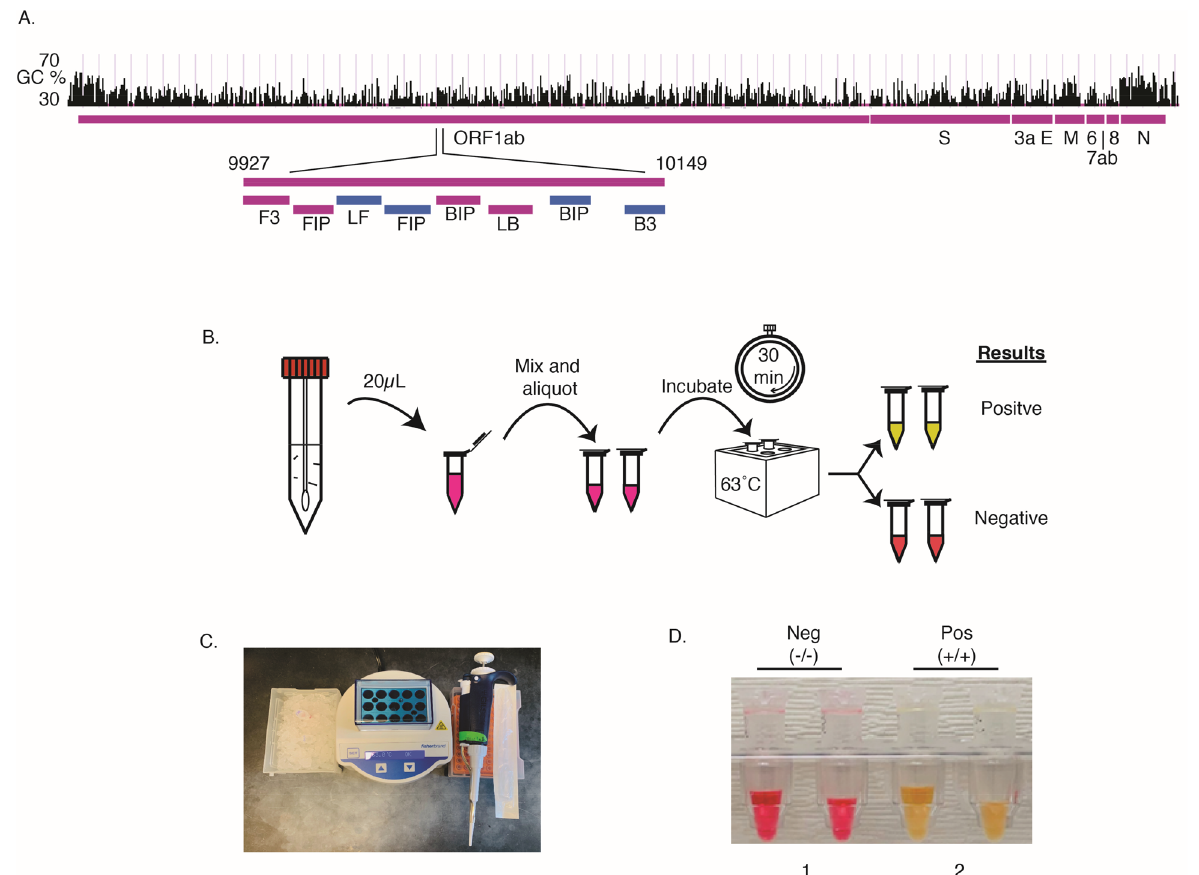
Figure 1. An RT-LAMP assay for rapid and direct SARS-Cov-2 testing of clinical sample and the point-of-care. ( A ) Primer design. A set of 6 LAMP primers targeting the middle of the Orf1ab gene. Sequences and primers matching to the + strand of virus genome are in pink, while those matching to the—strand are shown in blue. Illustration of GC% of SARS-CoV-2 genome was from UCSC genome browser (http://genom e.ucsc.edu) 17,18 . ( B ) Workflow of direct RT-LAMP assay. 20 µL of raw clinical samples from nasal swab in viral transport media (VTM) was added to 480 µL reaction solution consisting of reaction master mix and lysis buffer, mixed and 250 µL were aliquoted with a transfer pipette and then incubated on heatblock for 30 min. The reaction was stopped by placing the samples on ice and results were interpreted by color due to a pH sensitive dye in the master mix (yellow = positive; red = negative). ( C ). Setup of the RT-LAMP assay. ( D ). An example of colorimetric results on negative and positive clinical